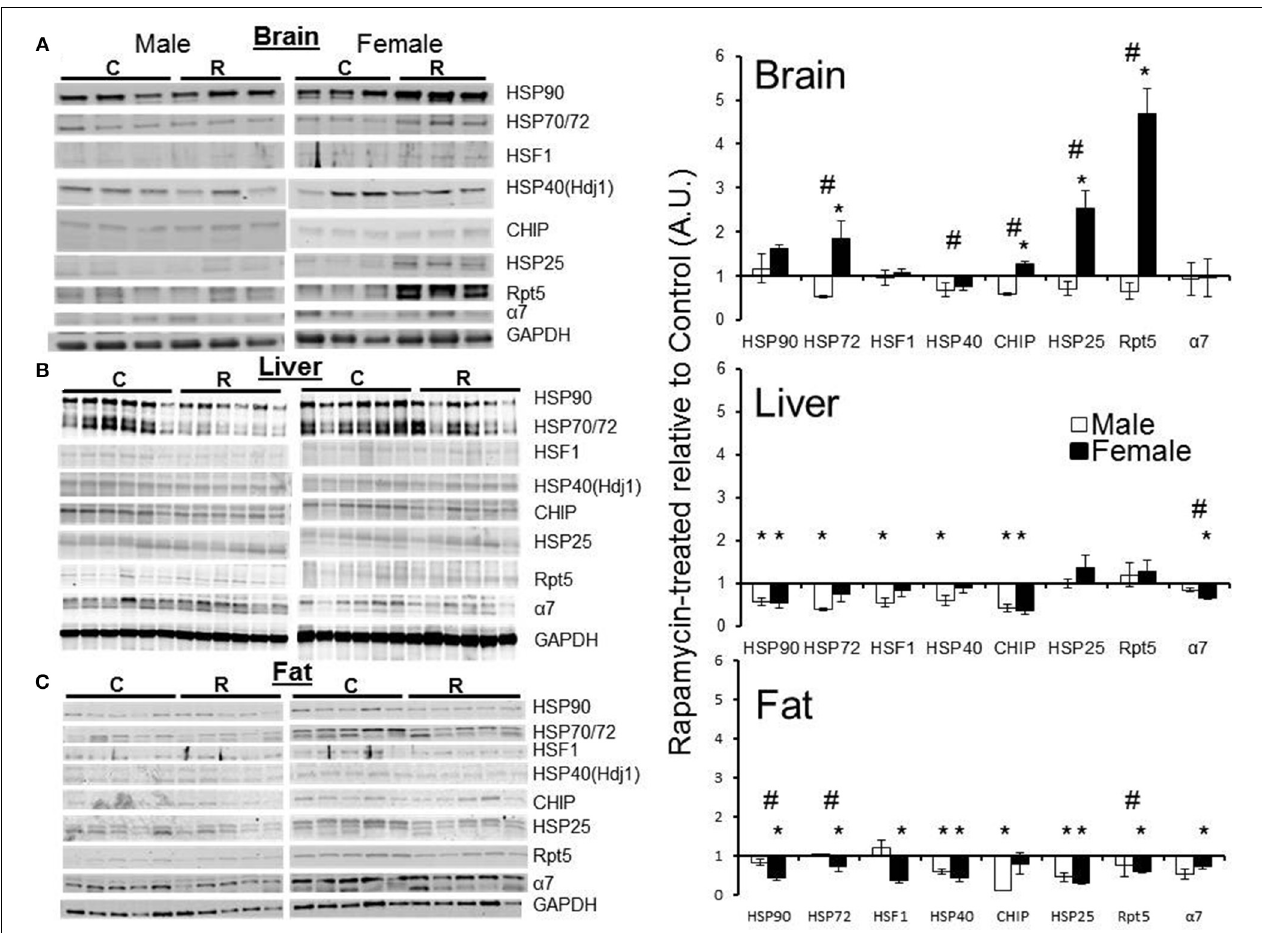
FIGURE 5 | Both proteasome subunits and proteasome-related chaperones in brain, liver, and visceral fat lysates revealed tissue and sex dependent treatment-related changes. Changes in protein expression as measured by Western blots relative to GAPDH, and normalized to old control in brain lysates from old (25 mo) male and female rapamycin-fed mice (A) indicated a female-specific, treatment-related increase for HSP72, HSP40, CHIP, HSP25, and RPT5. All these proteins also showed sex-dependent differences as well. In liver lysates (B) both sexes showed a